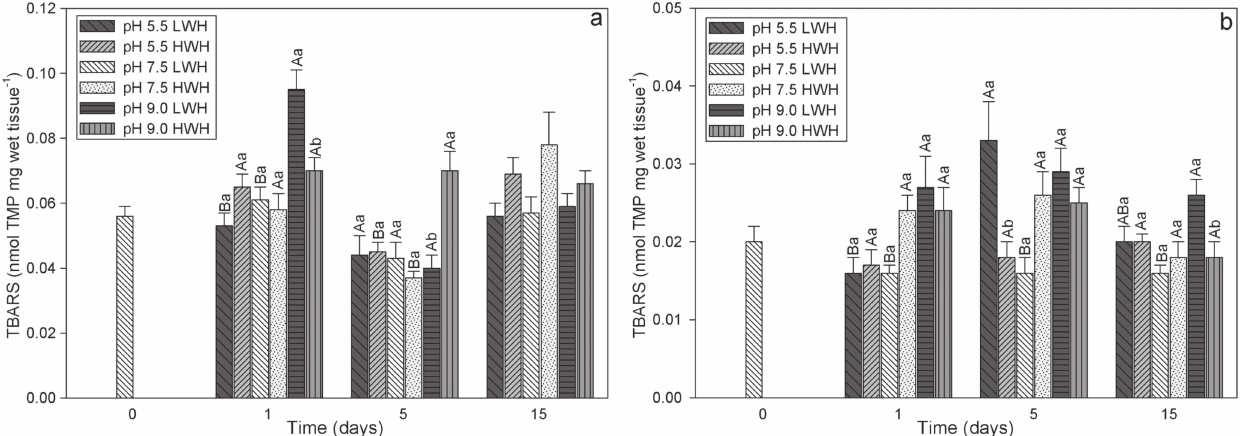
Fig. 3. Thiobarbituric acid reactive substances (TBARS) content (nmol TMP mg wet tissue -1 ) in a. gills and b. kidney of pacu ( Piaractus mesopotamicus ) juveniles under different water hardness and pH at different times. LWH = low water hardness (50 mg CaCO L -1 ); HWH = high water hardness (120 mg CaCO L -1 ). Data are presented as the means ± SEM (n = 3 3 9 fish treatment –1 ). Different uppercase letters indicate statistically differences between pH at the same hardness (P < 0.05). Different lowercase letters indicate statistically differences between hardness at the same pH (P <